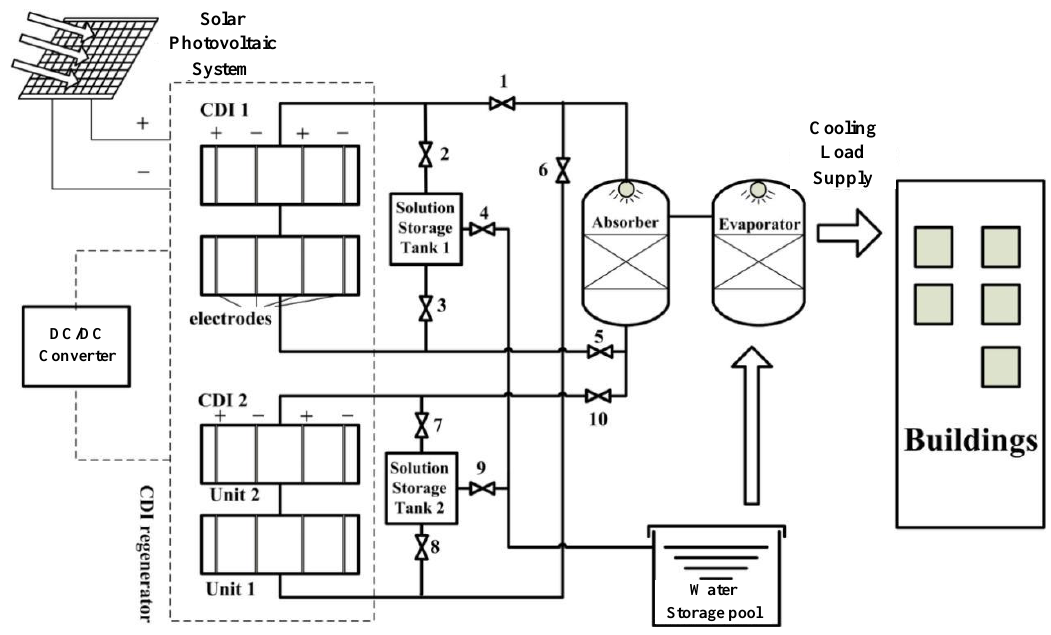
Figure 3. Flow chart of the double-stage CDI absorption air-conditioning system.